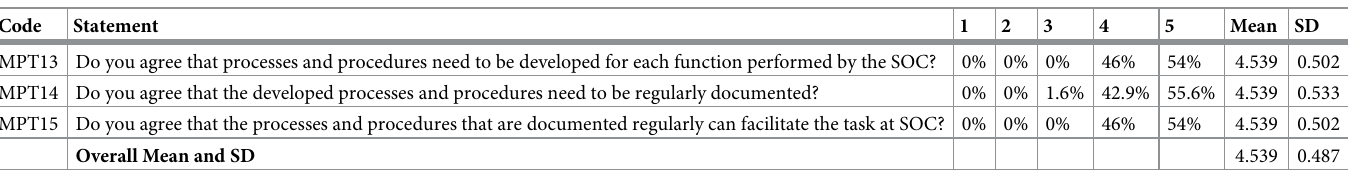
Table 12. Questionnaire results of process factors.